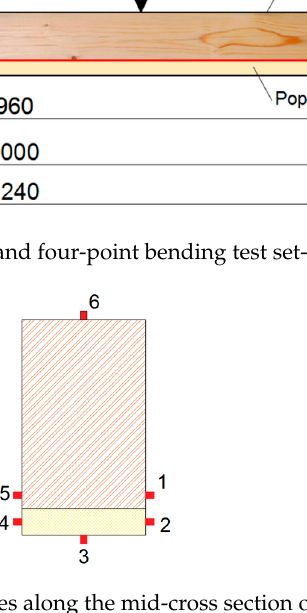
Figure 3. Strain versus time for beams RB_P_1 (failure mode type A) and RB_P_FC_1 (failure mode type B).